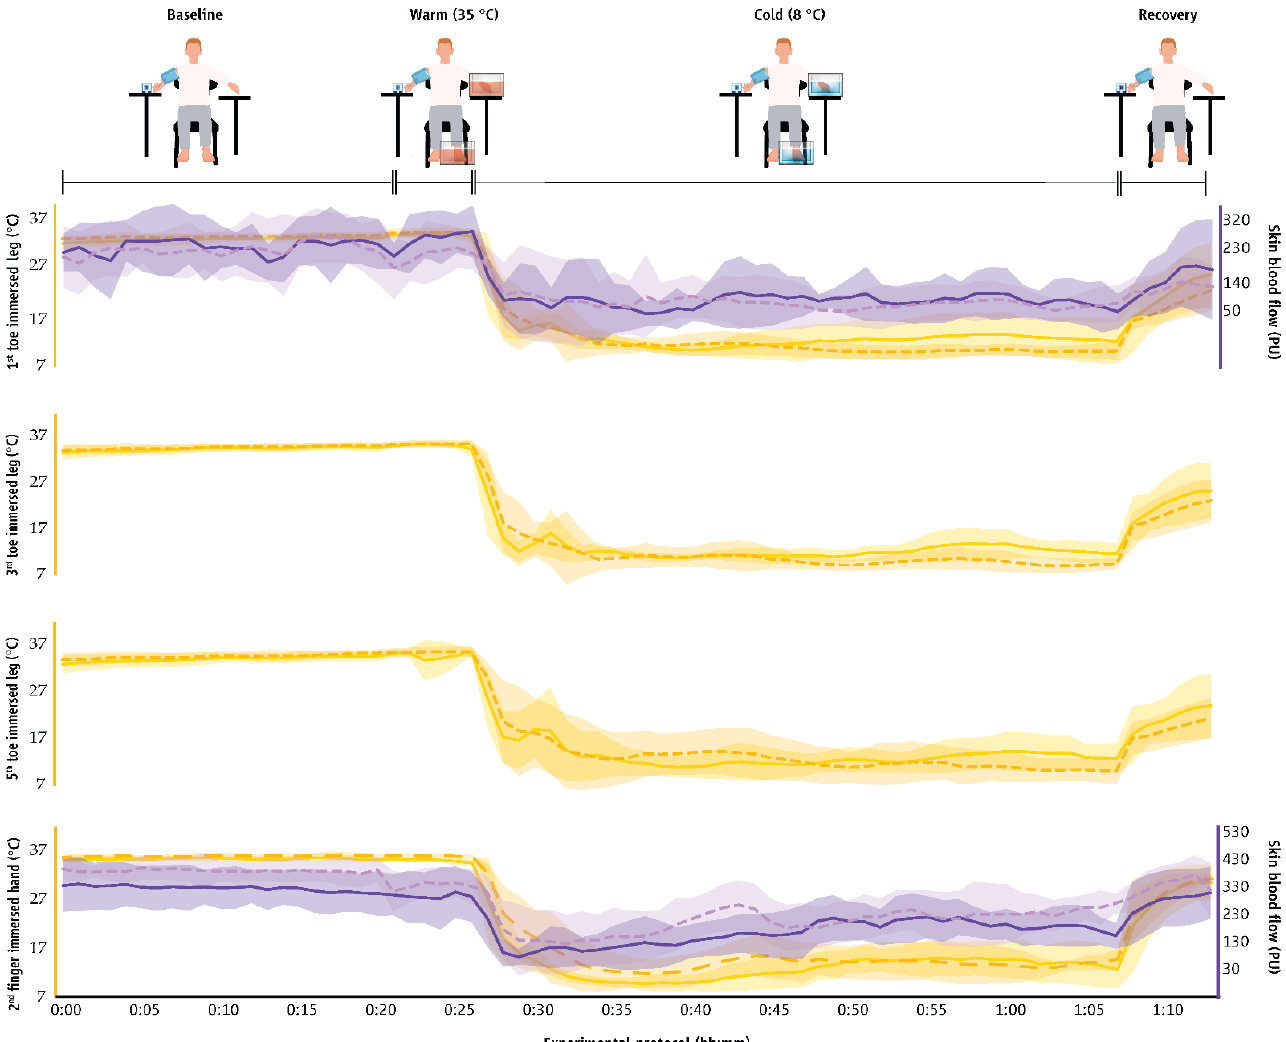
cold-water immersion, and the final five min (00:70 to 00:75) show responses during the recovery phase. Finger and toe temperatures are indicated with continuous yellow lines in men and with dashed yellow lines in women. Finger and toe skin blood flow data are indicated with continuous purple lines in men and with dashed purple lines in women.